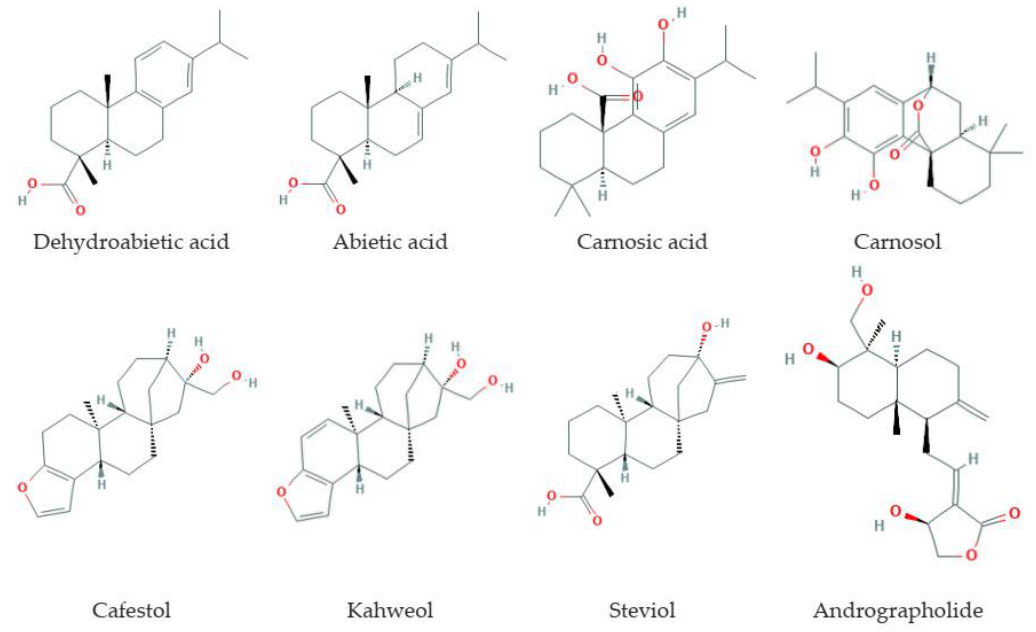
Figure 3. Some diterpenes that increase lifespan and delay age-related diseases.